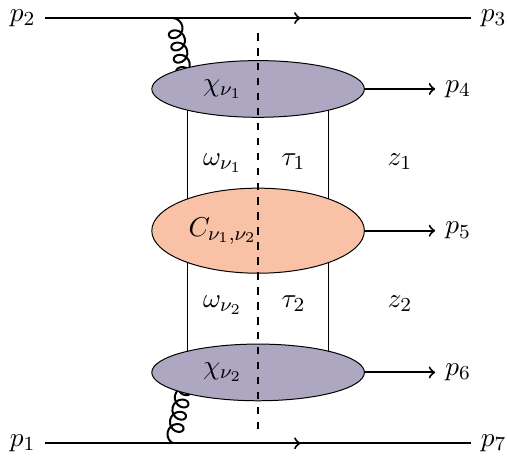
Figure 2 . Structure of the seven point amplitude in